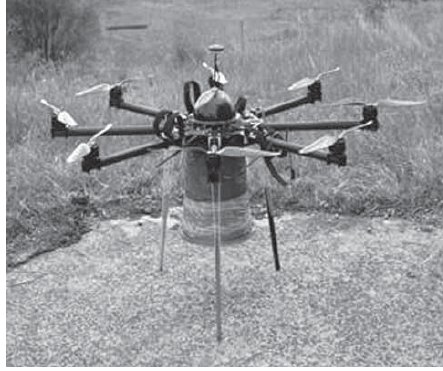
Figure 1. UAV-mounted gamma spectrometric complex (Zabulonov et al.,